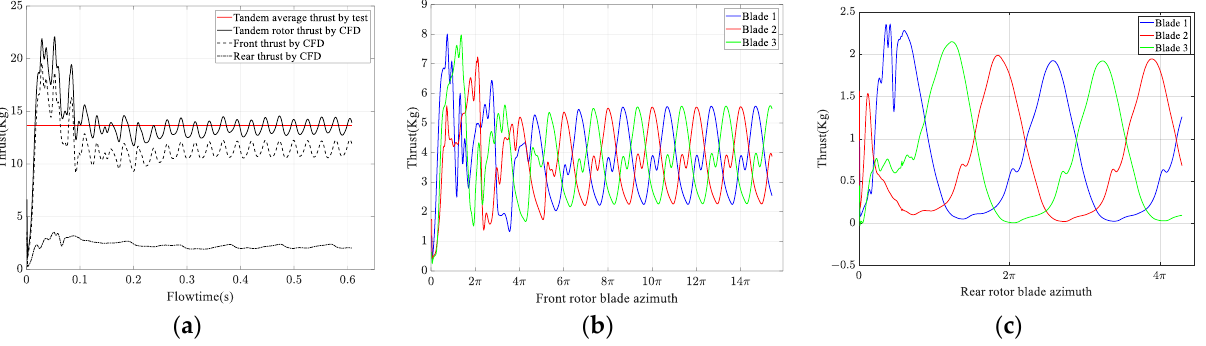
Figure 13. Numerical results of tandem rotor forward autorotation at V x = 15 m/s, θ = 10 deg , θ 0 = 3 deg. ( a ) Convergence process of the rotor thrust compared with test results; ( b ) front rotor blade thrust; ( c ) rear rotor blade thrust.